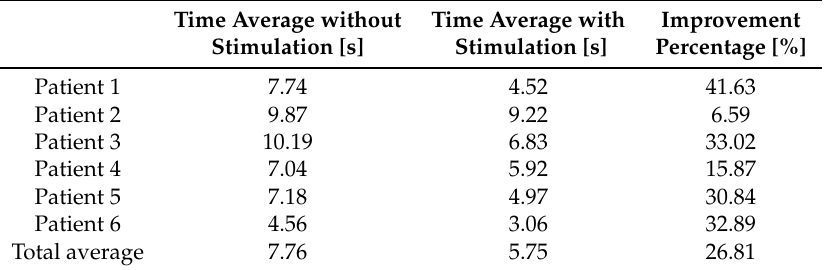
Table 5. FOG time with stimulation and without